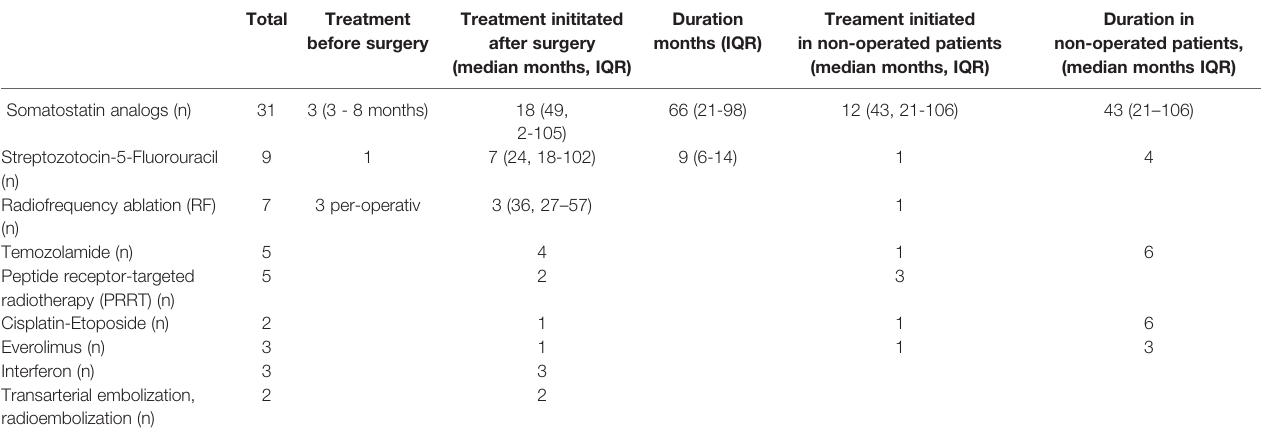
TABLE 3 | Pharmacotherapy, ablation, embolization and receptor-targeted therapy in pan-NETs patients.